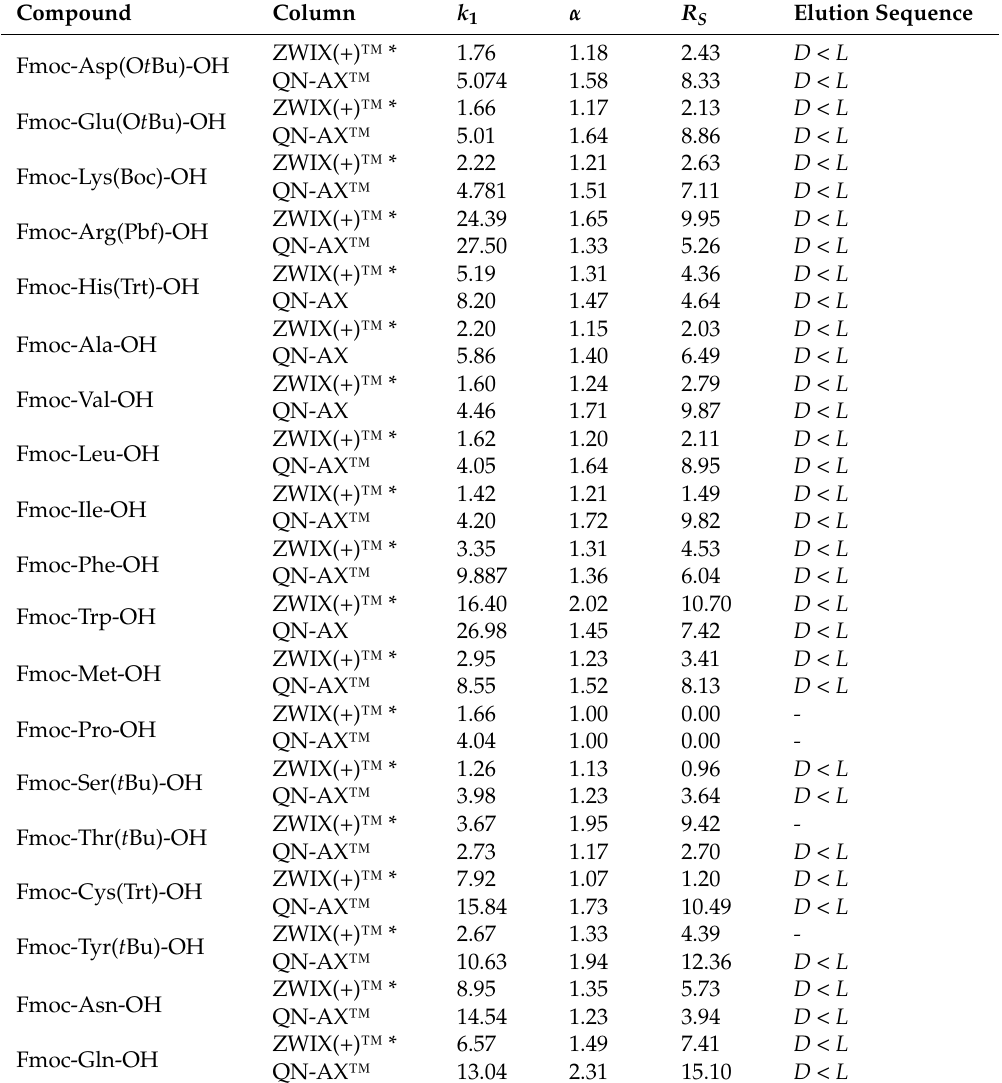
Table 2. Chromatographic data, retention factor ( k ), selectivity factor ( α ), resolution ( R S ) and elution sequence of N -Fmoc-protein amino acids on ZWIX(+)™ and QN-AX™ CSPs at SFC condition.